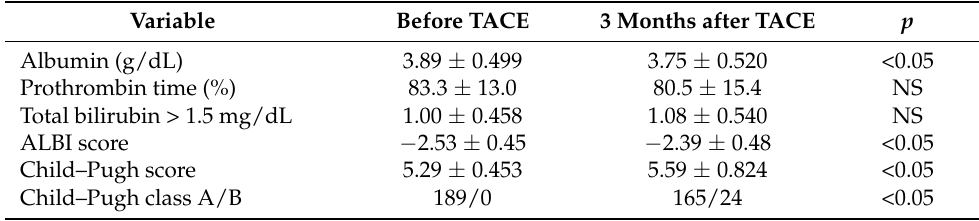
Table 3. Changes in liver function after TACE.